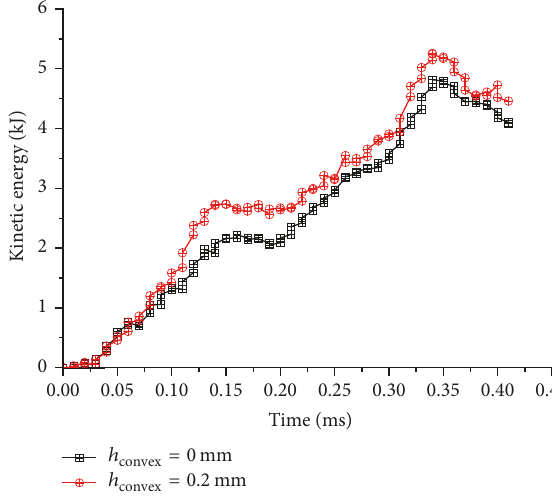
Figure 8: Average bond force of the target particle.